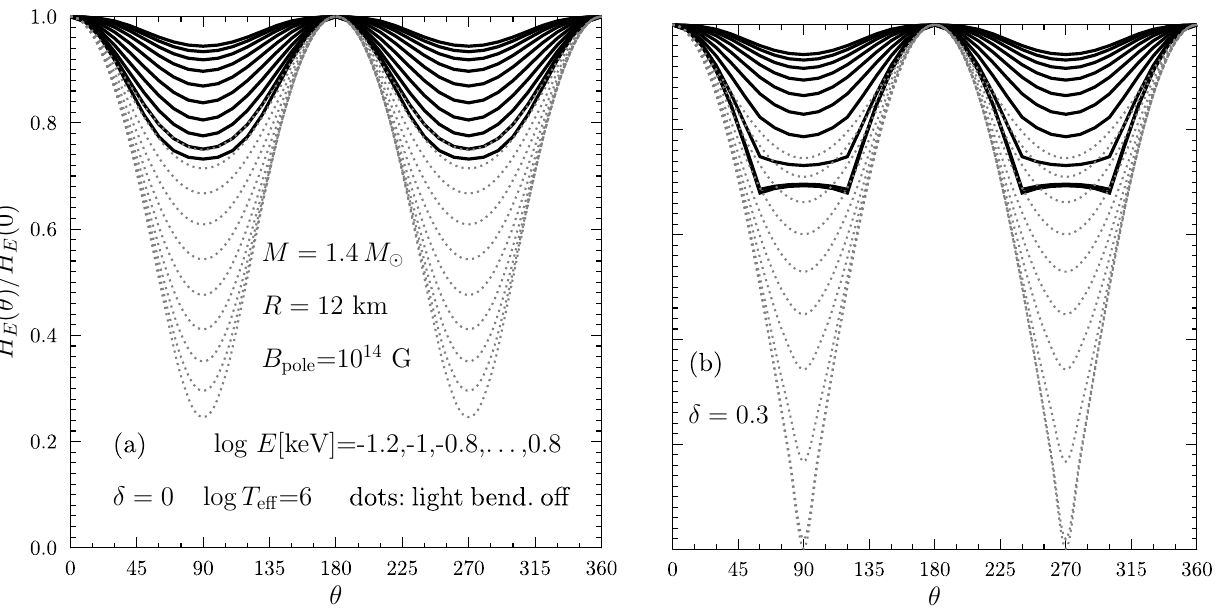
Figure 7. Theoretical lightcurves, normalized to pole observations, versus phase angle θ for a neutron star with T eff = 1 MK and B pole = 10 14 G; ( a ) δ = 0 (no extra pole heating) and ( b ) δ = 0.3. Solid curves are for photon energies log E [keV]= 1, 0.8, . . . ,0.8 (from top to bottom). The two lowest curves on panel ( b ) (with highest E ) almost coincide. − − Dotted curves show the same but neglecting gravitational light bending. The star is assumed to be orthogonal rotator with the spin axis perperndicular to the line of